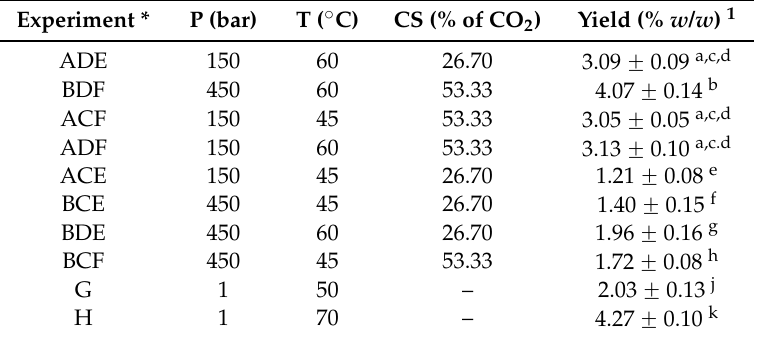
Table 1. Experimental matrix design for conditions for supercritical fluid extraction (SFE) and microwave-assisted extraction (MAE), and extraction yields of Arthrospira platensis